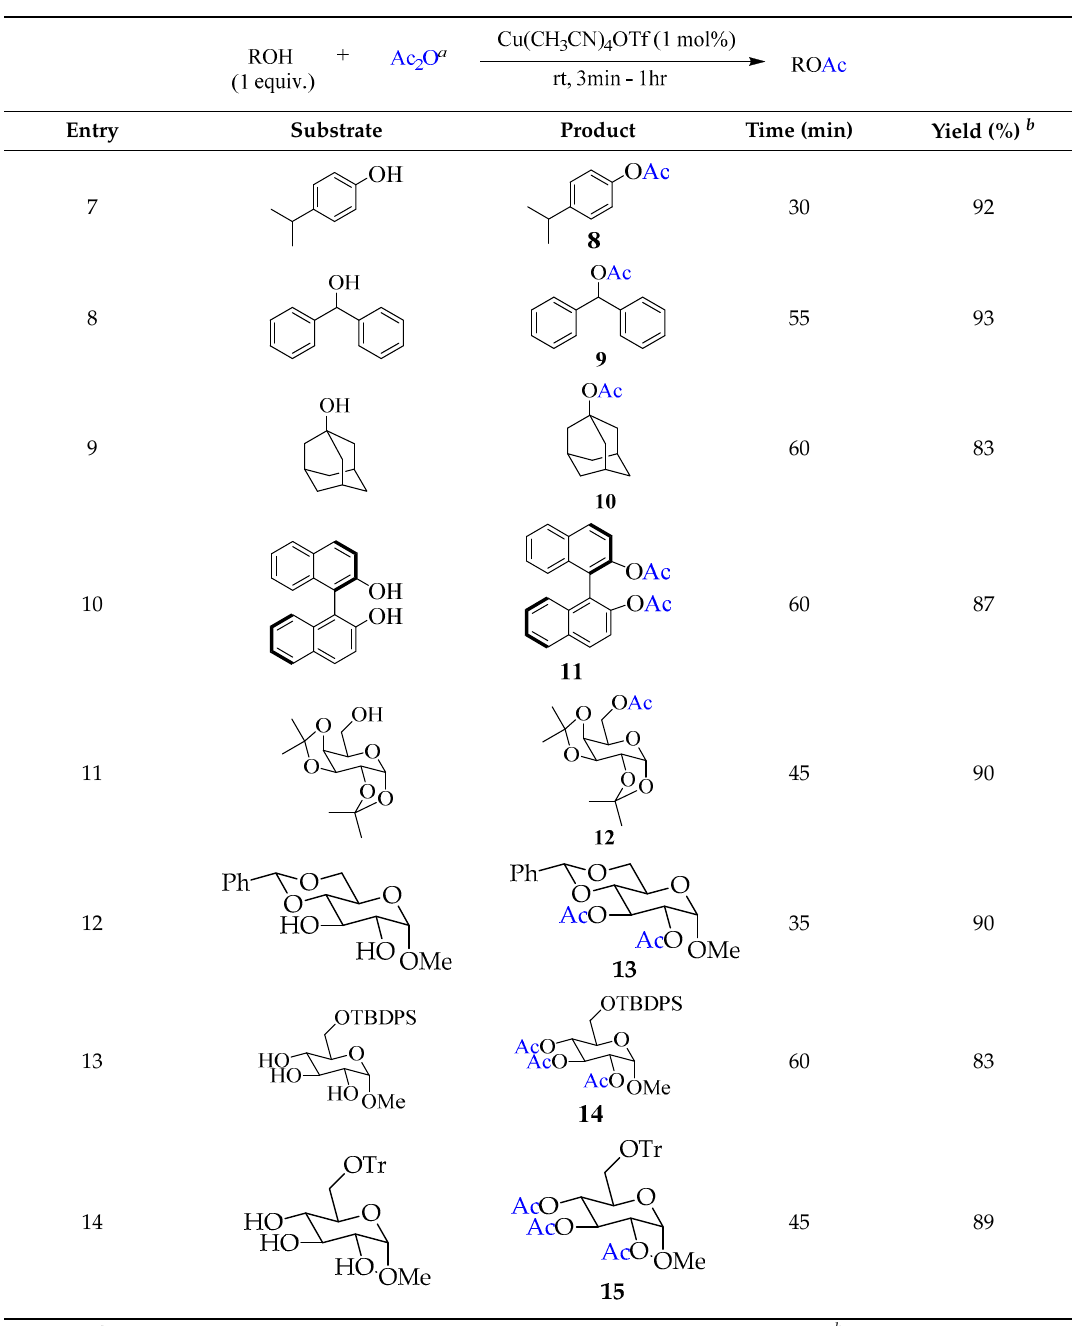
Table 1. Cont. Table 1. Acetylation of alcohols with acetic anhydride catalyzed by Cu(CH 3 CN) 4